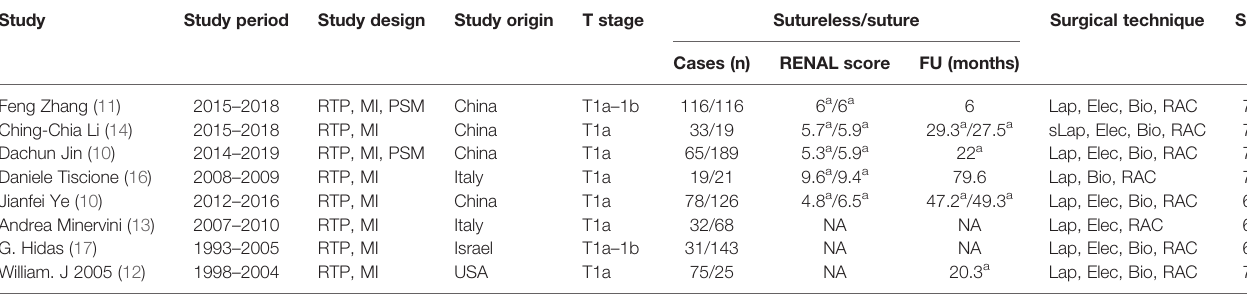
TABLE 1 | Summary of baseline characteristics of the studies included in the meta-analysis. Study